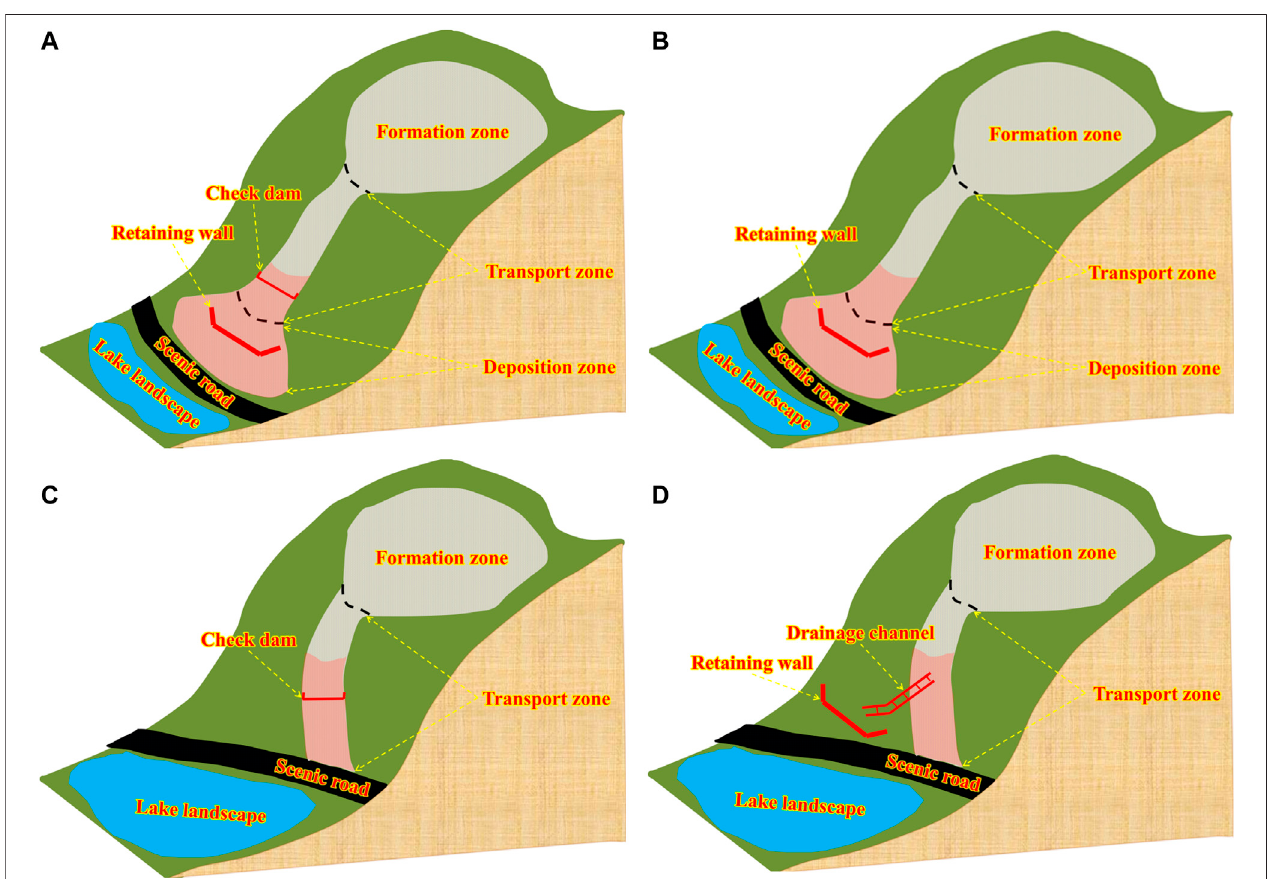
FIGURE 11 | Control modes of debris fl ow disasters in scenic areas. (A) Engineering countermeasures with blocking and deposit stopping measures. (B) Engineering countermeasures with deposit stopping measures. (C) Engineering countermeasures with blocking measures. (D) Engineering countermeasures with drainage and deposit stopping measures. The light red shaded regions represent the area for the construction of debris fl ow control projects, which can be obtained through the method in Delimiting the Area for the Construction of Debris Flow Control Projects section.